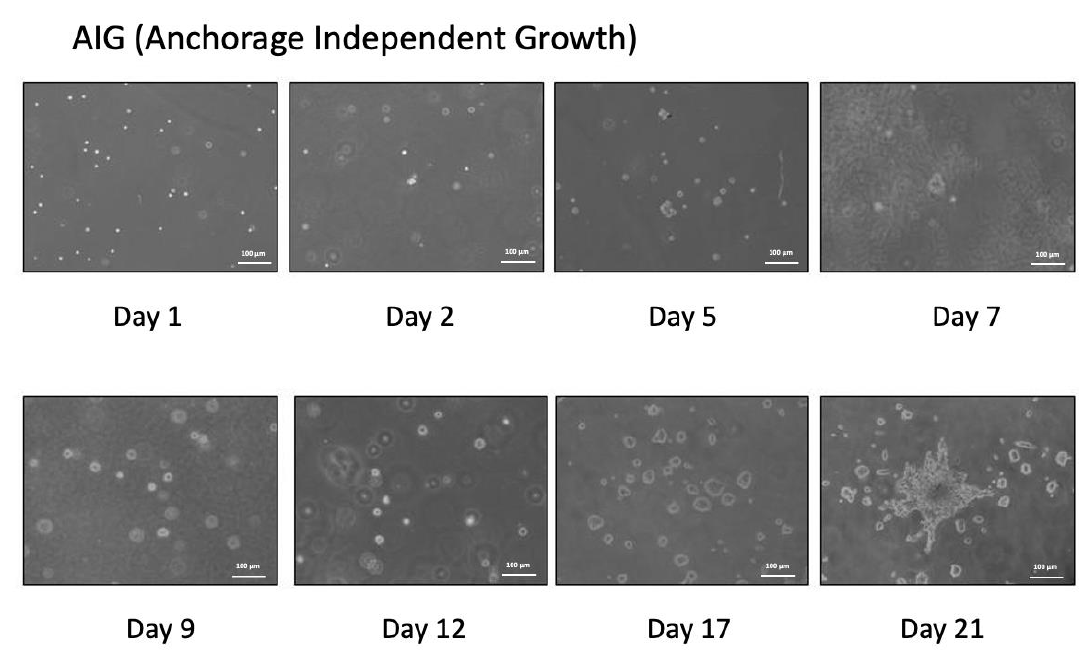
Figure 2. The anchorage independent growth of HBMSC cultured in BK medium. Cells can grow and have surprisingly high frequencies of AIG.